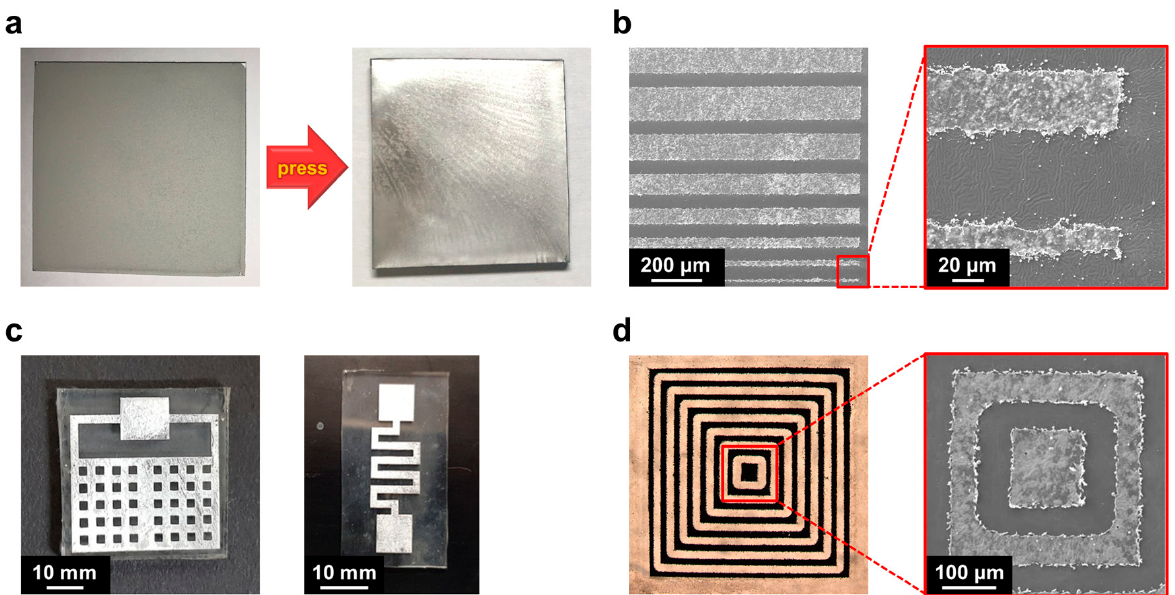
Figure 2. ( a ) Photographs of (left) a dried suspension of Galinstan microdroplets in thin-film form on a flexible PDMS substrate, and (right) a conductive Galinstan film fabricated by compression and separation using PDMS. ( b ) SEM images of patterned Galinstan films, of which the minimum line width is ~20 µ m. ( c ) Photographs of exemplary Galinstan films, patterned by laser ablation. ( d ) Optical microscopy image and its close-up SEM image of an exemplary Galinstan structure with complex pattern.